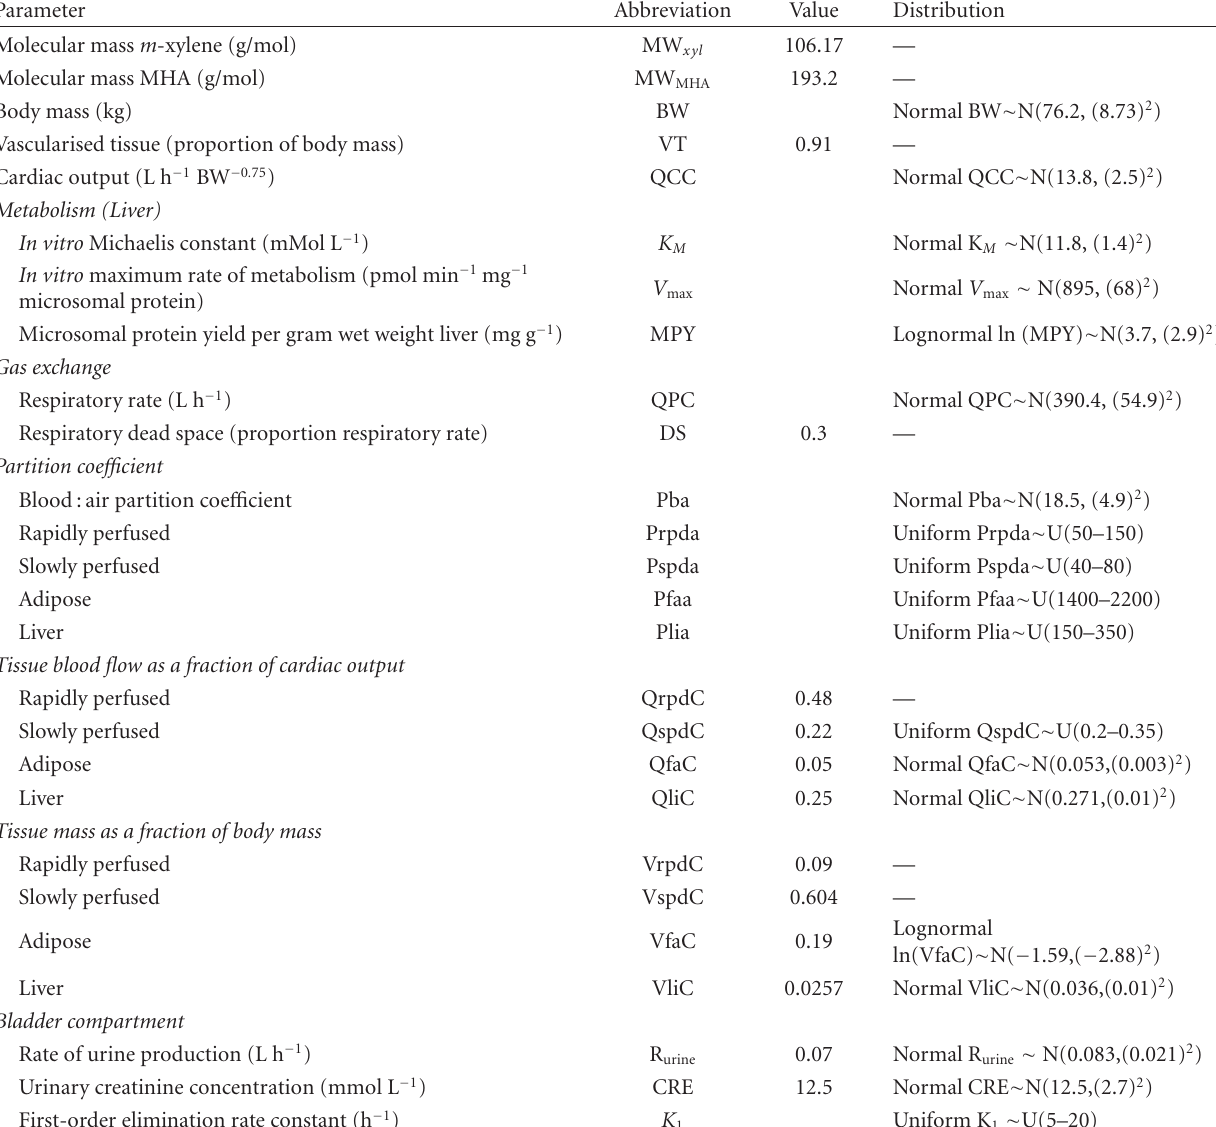
Table 2: Anatomical, physiological, and kinetic constants and parameters used in the PBPK